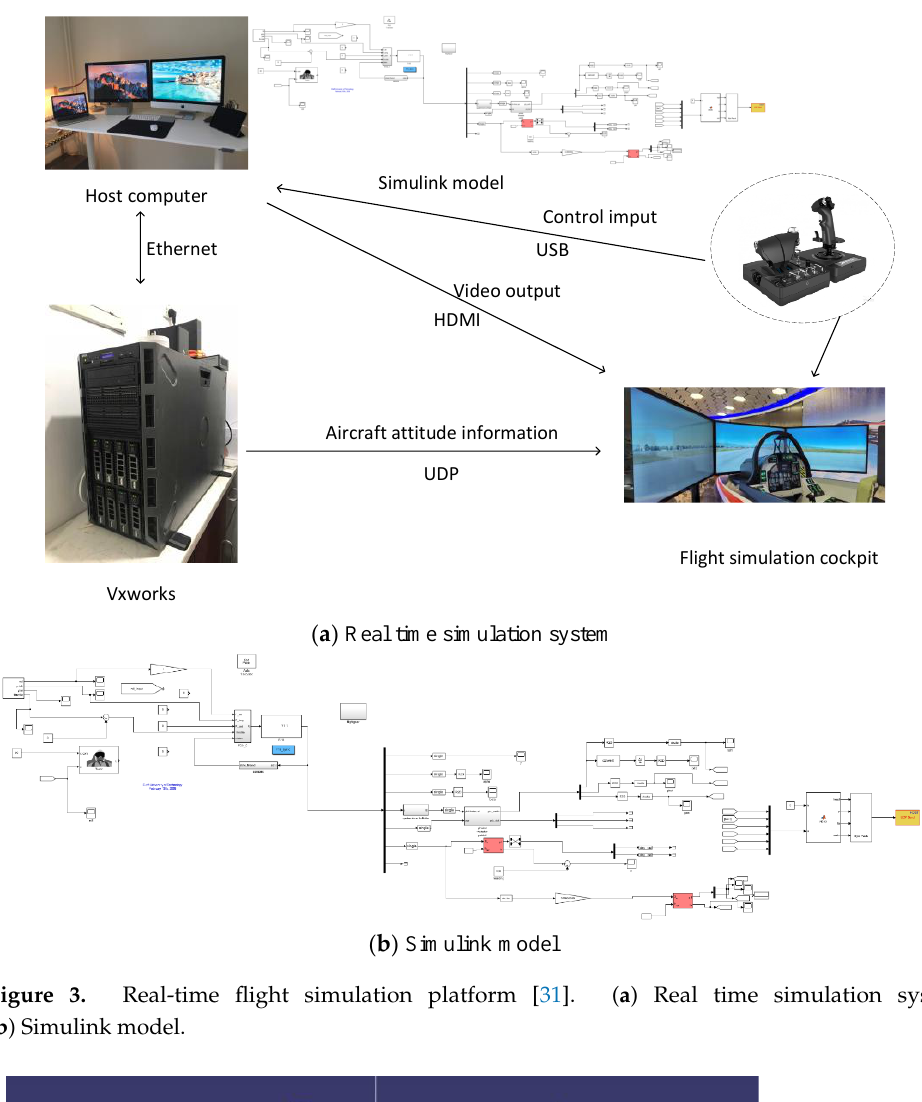
Figure 3. Real-time flight simulation platform [31]. ( a ) Real time simulation system. ( b ) Simulink model.